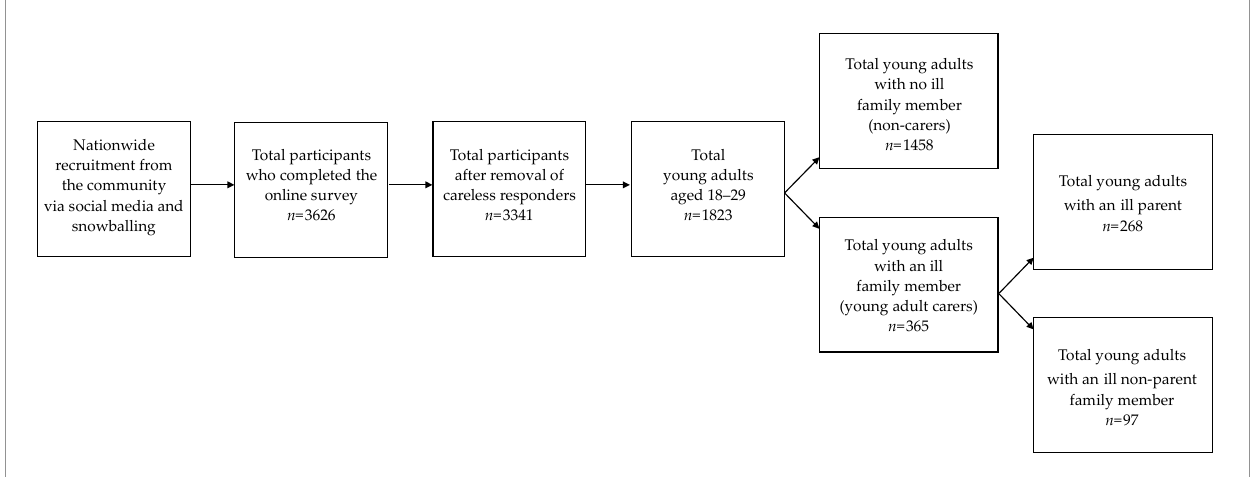
Figure 1. Flow chart depicting participant selection into this study.